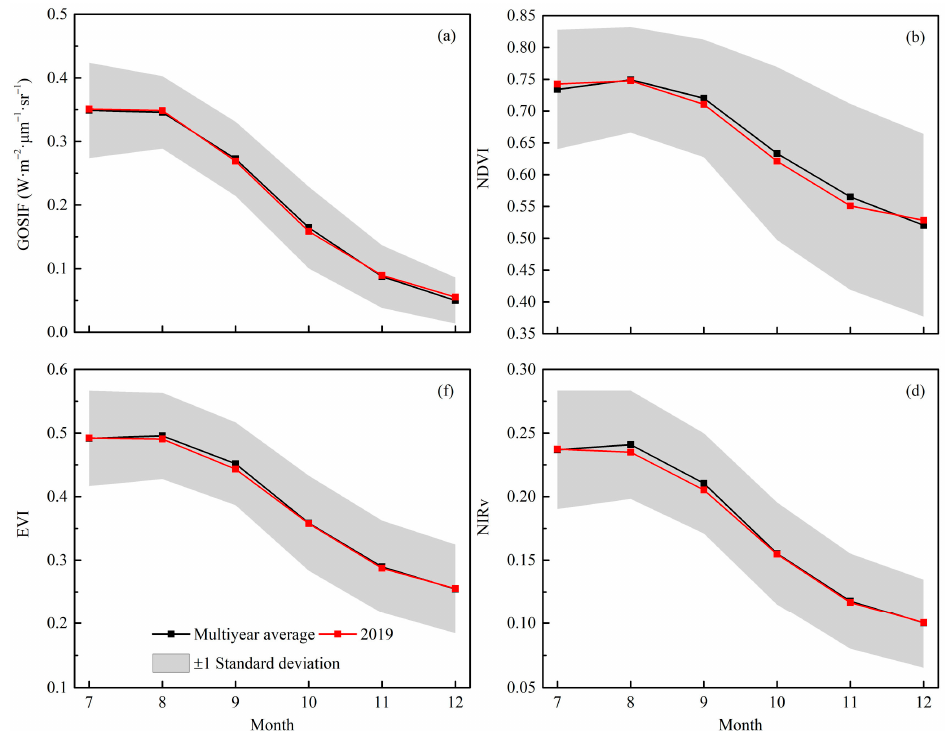
Figure 9. Variations of GOSIF ( a ), NDVI ( b ), EVI ( c ), and NIRv ( d ) from July to December 2019. Note: The black curves denote the multi-year monthly averages of these variables during 2011–2020; the red curves denote the monthly average of these variables in 2019; the grey shaded areas denote the ±1 standard deviation of the multi-year monthly averages.